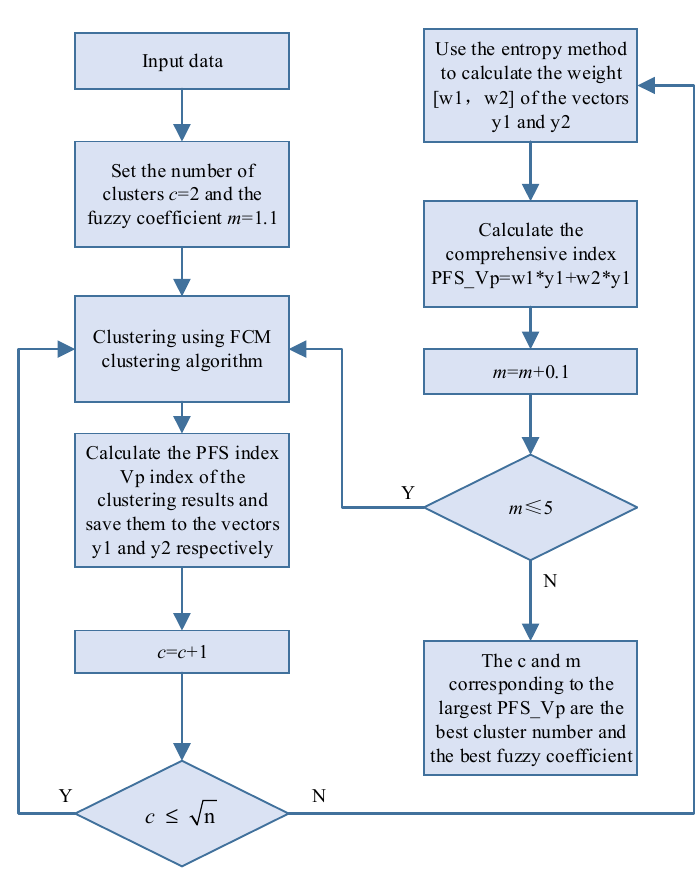
Figure 1. Improved FCM algorithm flow chart.